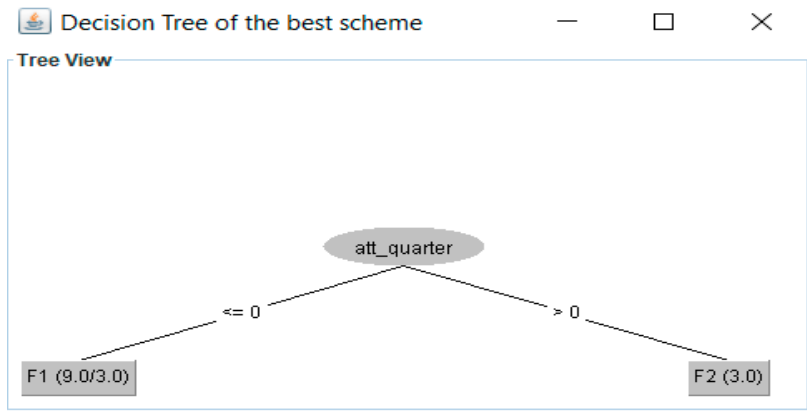
Figure 10. Comparison of fragmentation schemes with 2 and 3 fragments.